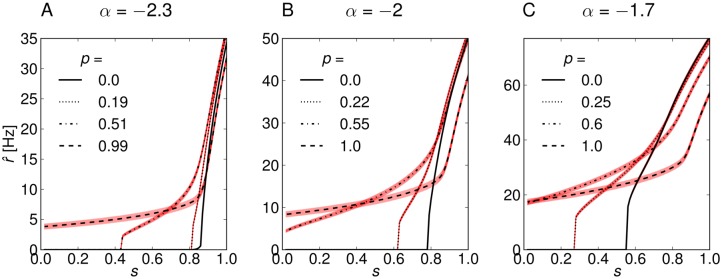
Response curves of three model networks with power-law in-degree distribution P
in(k) ∼ k
α, k = [10, … 500] and slightly different exponents α.For each network we show the response curves for four different levels of assortativity (thin black lines). The thick light red lines indicate ±1SD of the noise of the output from n = 5000 neurons. (A) Model network with large negative exponent of α = −2.3 and small mean degree. The network responses to sub-threshold stimuli are very weak due to small recurrent activity. The uncorrelated network (p = 0) begins to fire above the stimulus threshold of s > 0.8. This threshold is reduced for increasing assortativity, and the response becomes very noisy. (B) Model network with intermediate exponent α = −2 and intermediate mean-degree. The network responses are stronger than for α = −2.3, but the stimulus threshold for the uncorrelated network is similar at s ≃ 0.8. (C) Model network with small negative exponent and large mean degree. The network fires at high rates and has a low stimulus threshold s ≃ 0.55 due to strong recurrent activity.